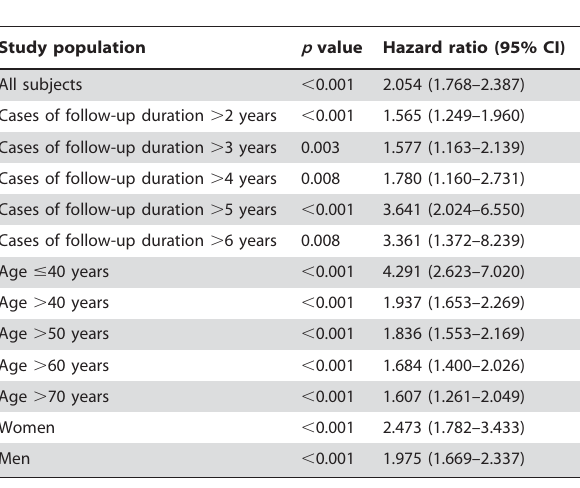
Table 3. Impact of pulmonary TB on developing COPD in sensitivity analyses.